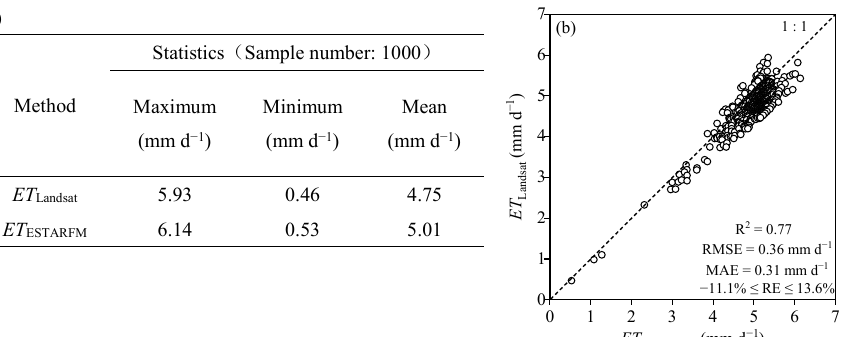
Figure 3. Distribution maps of ET in cotton fields under film-mulched drip irrigation in the Manas River Basin, respectively estimated using SEBS based on the remote sensing images from Landsat ( ET Landsat ) or MODIS ( ET MODIS ), and using ESTARFM ( ET ESTARFM ) based on the fusion of ET Landsat and ET MODIS : ( a ) ET MODIS and ( b ) ET Landsat on 14 June 2018; ( c ) ET MODIS and ( d ) ET Landsat on 17 August 2018; ( e ) ET MODIS , ( f ) ET Landsat , and ( g ) ET ESTARFM on 1 August 2018; ( h ) Selected partial detail distribution of ET in ( f ); ( i ) Correspondingly selected partial detail distribution of ET in ( g ), in comparison with that of ( h ); ( j ) Absolute errors of ET between ( h , i ) (|AE|); and ( k ) Absolute relative errors of ET between ( h , i ) (|RE|).